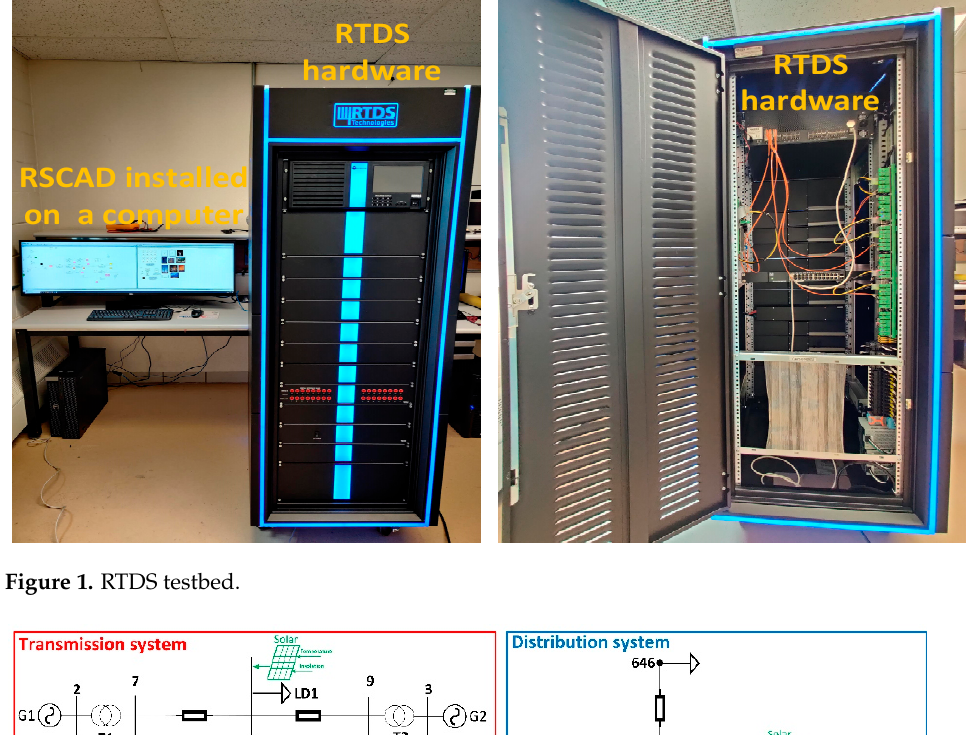
Figure 1. RTDS testbed.